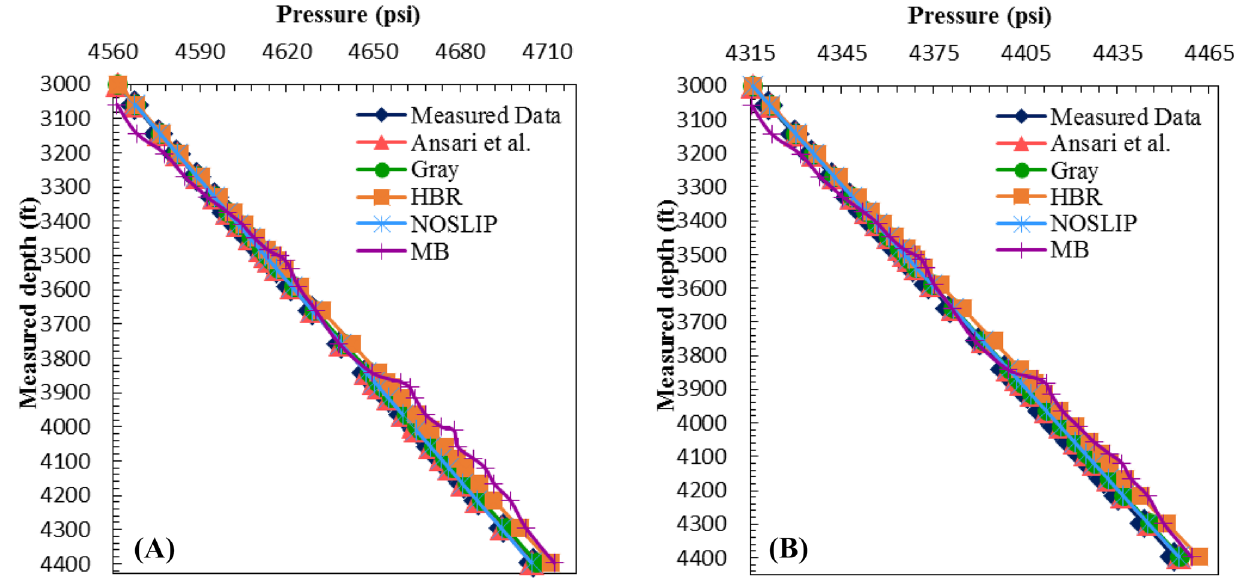
Fig. 7 Comparison of tubing pressure drop models in a Q = 60 MMSCFD and b Q = 120